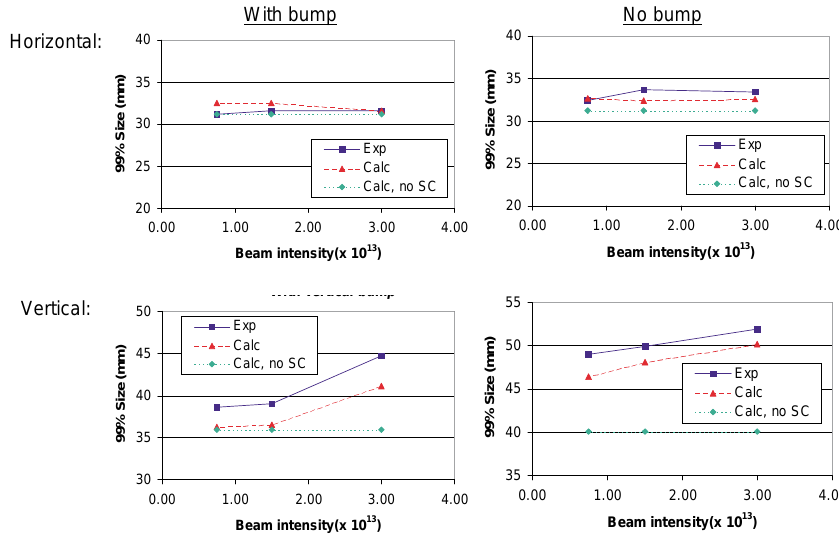
FIG. 6. (Color) Horizontal and vertical 99% beam size versus beam intensity for cases with and without the vertical injection bump.